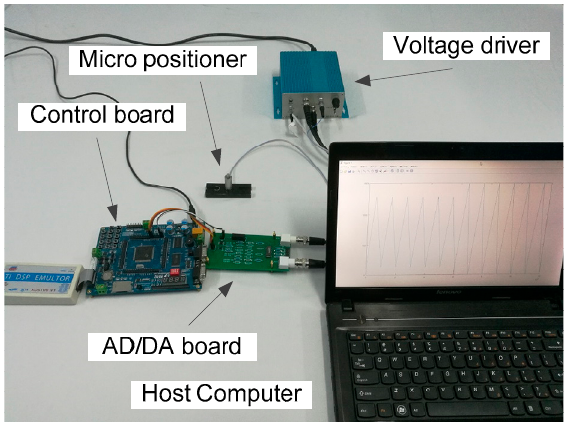
Figure 9. Experimental system.